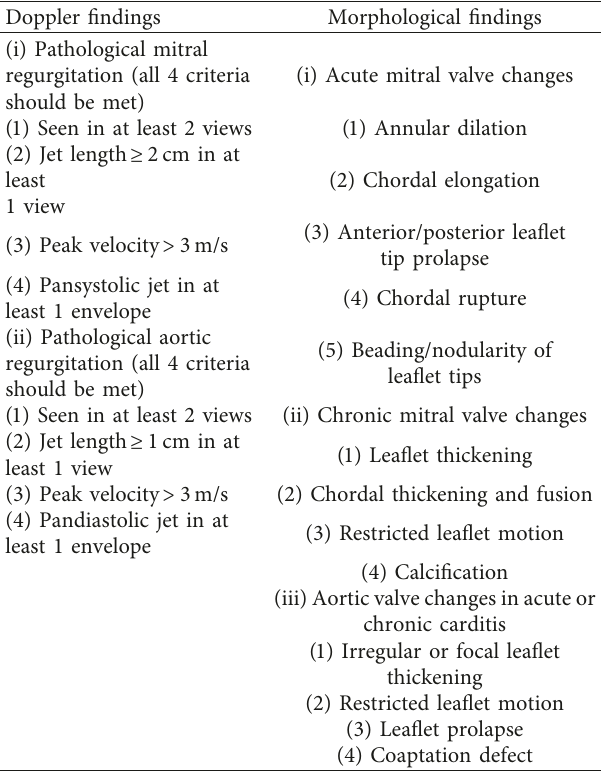
Table 1: Doppler and morphological findings in rheumatic valvulitis. Doppler